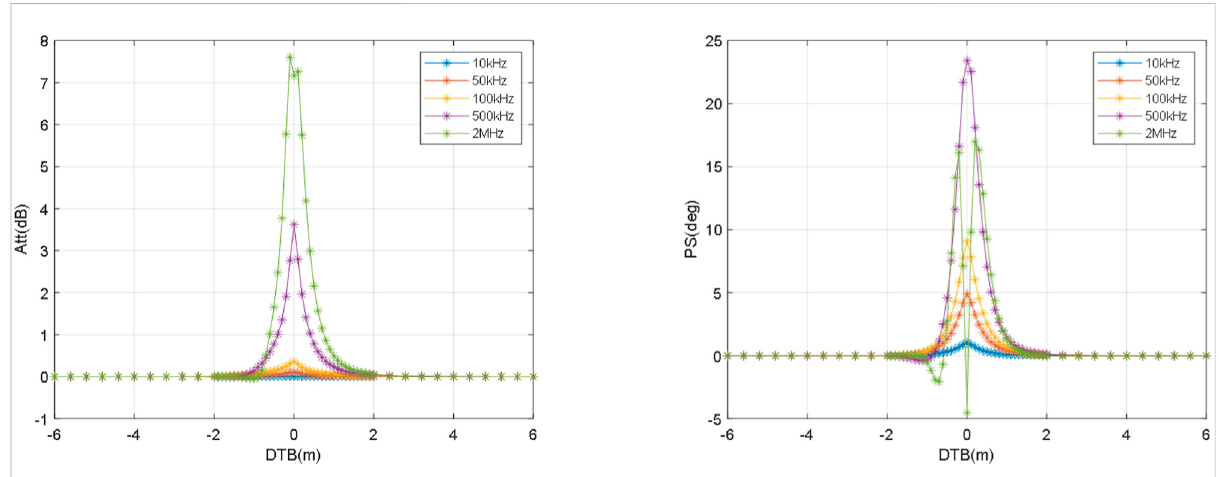
FIGURE 8 Response of the tilted receiver at different frequencies.